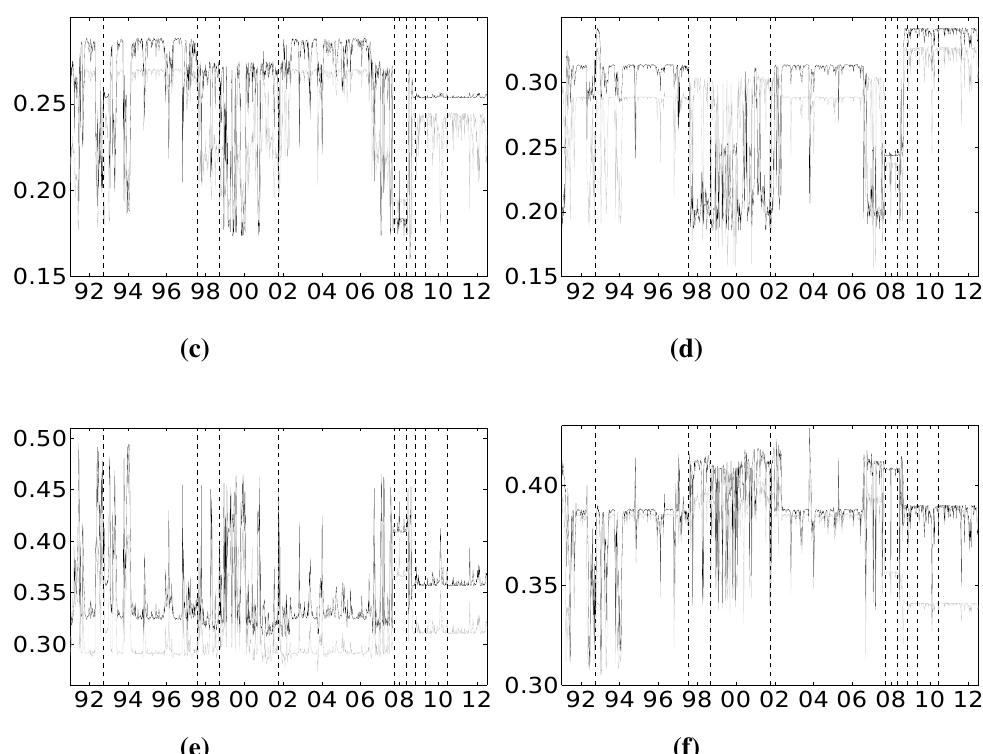
Figure 7. Comparisons of Shapley values ∆ M CoES for the different sectors. Vertical dotted lines represent major financial downturns: see Figure 1 for a detailed description. ( a ) Distress of banks on financial services (dark) and vice versa (light gray); ( b ) distress of banks on life insurance (dark) and vice versa (light gray); ( c ) distress of banks on non-life insurance (dark) and vice versa (light gray); ( d ) distress of financial services on life insurance (dark) and vice versa (light gray); ( e ) distress of financial services on non-life insurance (dark) and vice versa (light gray); ( f ) distress of life insurance on non-life insurance (dark) and vice versa (light